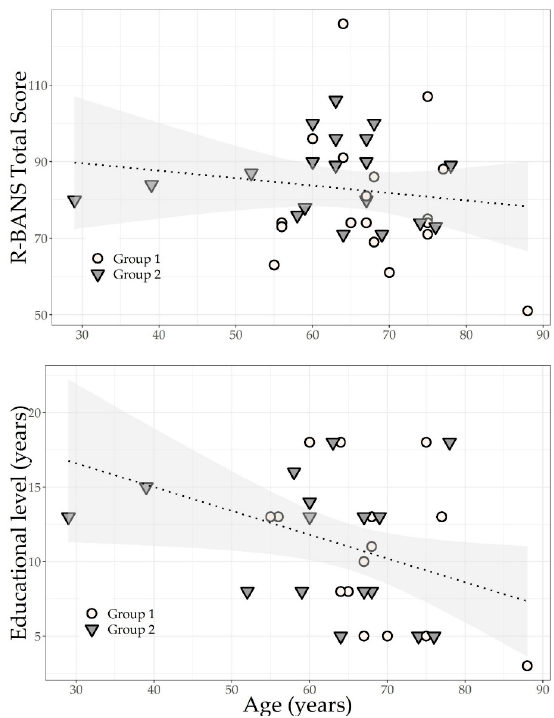
Figure 2. Scatter plots of the Repeatable Battery for the Assessment of Neuropsychological Status (R-BANS) total score according to the two groups studied, their age, and education (Group-1 = without invasive ventilation; Group-2 = with invasive ventilation).